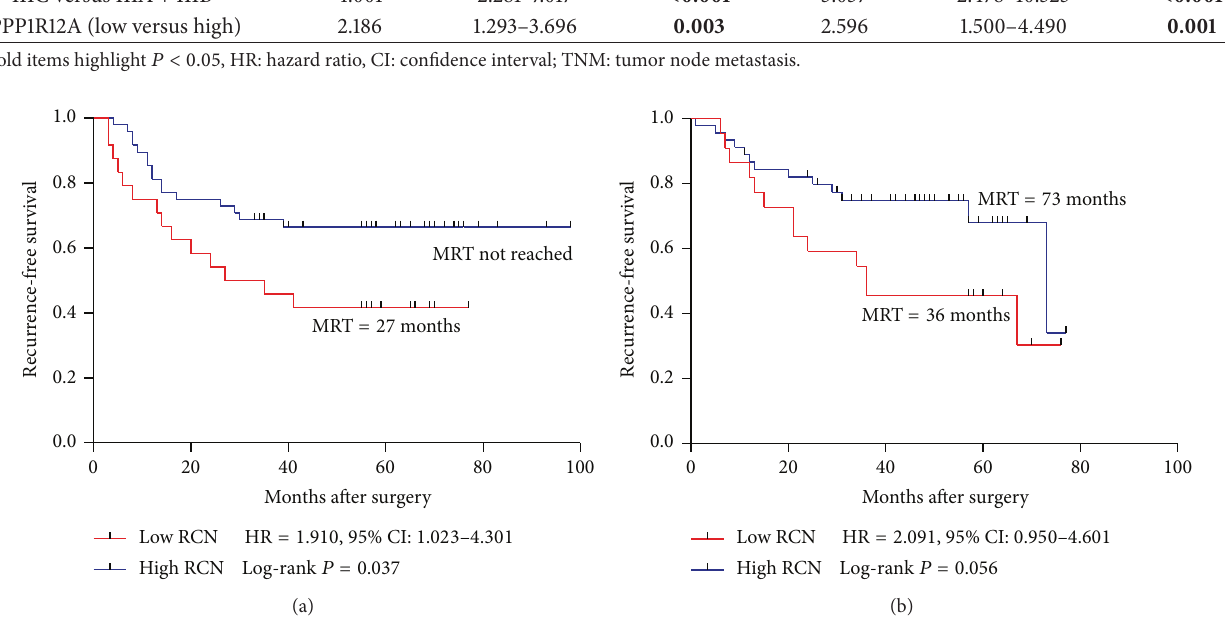
(IIIC: HR = 1.874 , 𝑃 = 0.065 , rectum HR = 2.091 , 𝑃 = 0.056 ) (Figures 1(c) and